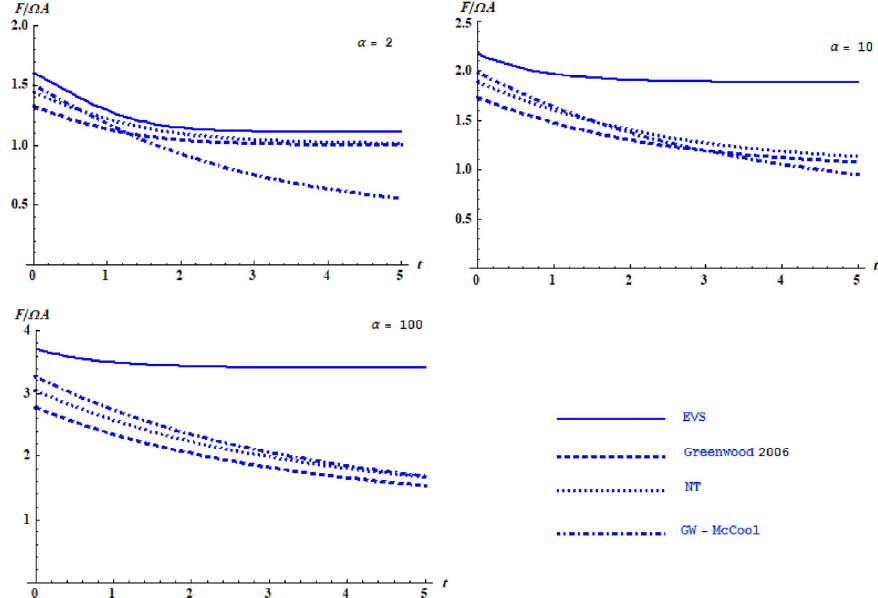
Fig. 10 When we use Gumbel distribution in GW- McCool model the value of pressure is more uniform than other